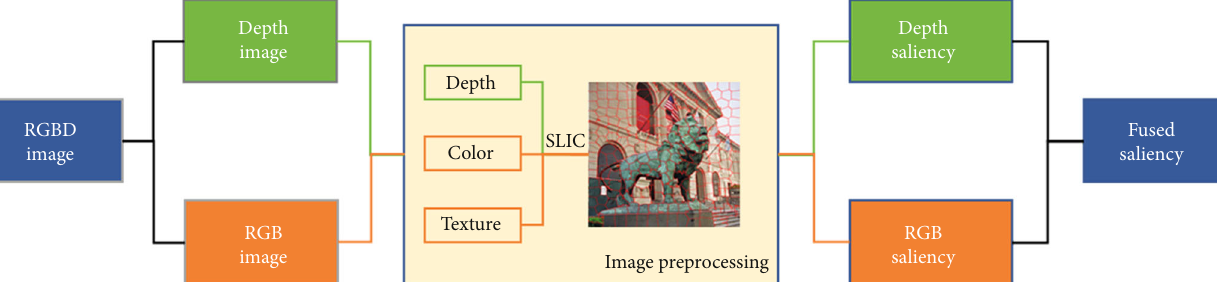
Figure 1: Our framework of saliency detection.